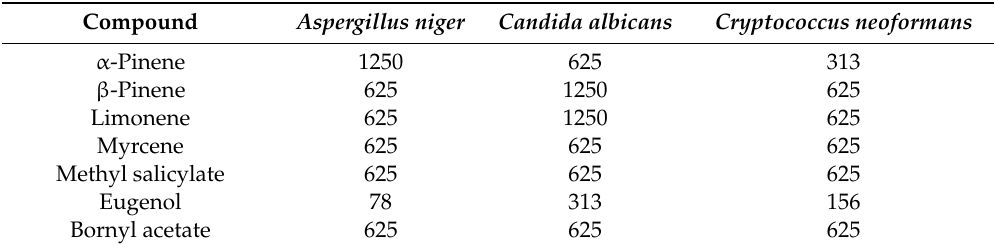
Table 13. Antifungal activities (MIC, µ g / mL) of essential oil